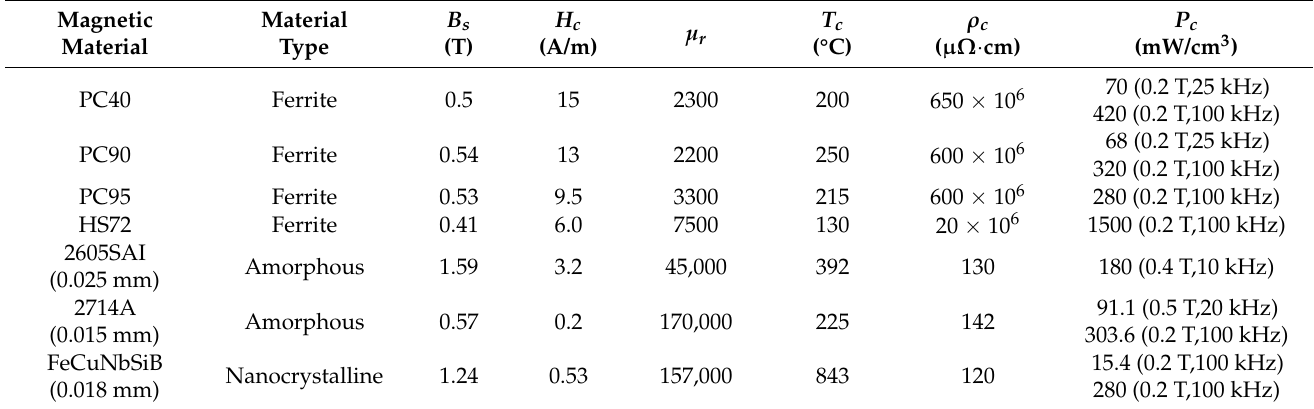
Table 9. Characteristic parameters of soft magnetic materials currently available on sale.